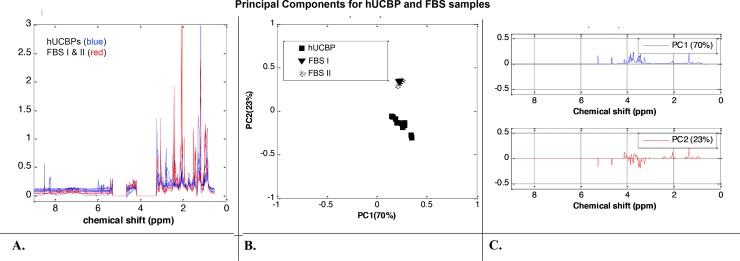
Metabolomic analysis of hUCBP and FBS samples.(A) 1H-NMR spectral trajectories of the hUCBP samples (blue colour) and FBS (FBS_I and FBS_II samples) (red colour) groups; (B) 2D (PC1 vs. PC2) PCA score plot shows close similarity of FBS_I and FBS_II data (a well-defined cluster with overlapping samples) and a separation from the hUCBP data and (C) corresponding loadings plots illustrate that glucose, lactate and acetates are the main metabolites contributing to the dissimilarity between the human plasma (hUCBP) and bovine sera (FBS_I and FBS_II) samples. Loading plots around zero line suggest close behaviour of the metabolites profiles in the spectral region from 9.0 ppm to 5.3 ppm of the three groups of samples (hUCBP, FBS_I and FBS_II samples).